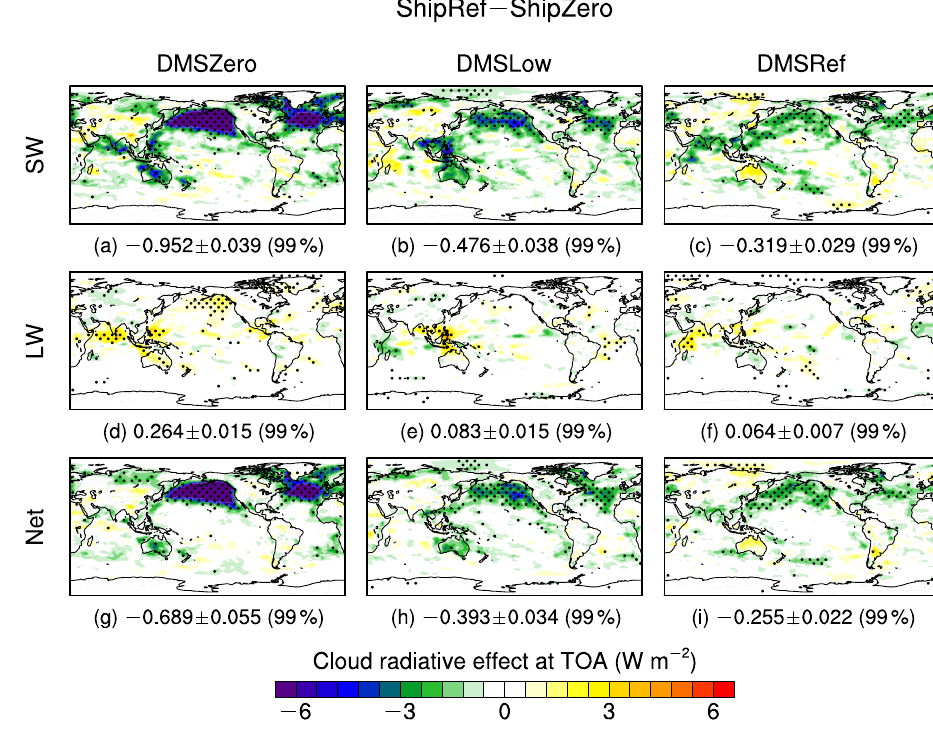
Figure 11. Same as Fig. 6, but using a different aerosol module, namely MAM3 rather than MARC.